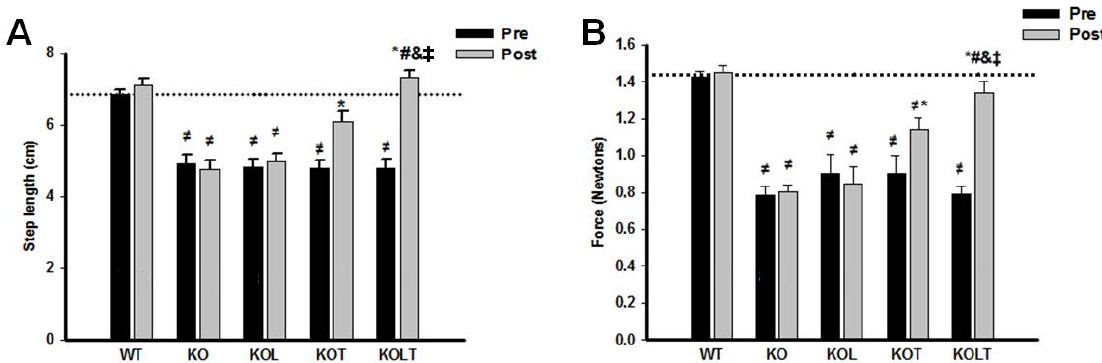
Figure 5. Indexes of skeletal muscle function. Ambulation test ( A ) and grip force ( B ) in control wild type (WT), α 2A / α 2C ARKO mice placebo (KO) or leucine (KOL), and exercise trained (KOT) or exercise trained and leucine-supplemented (KOLT). Data are presented as mean ± SE. n = 8–11/ group. * p < 0.05 vs. Pre; ≠ p <0.05 vs. WT; # p < 0.05 vs. KO; & p < 0.05 vs. KOL; ‡ p < 0.05 vs.